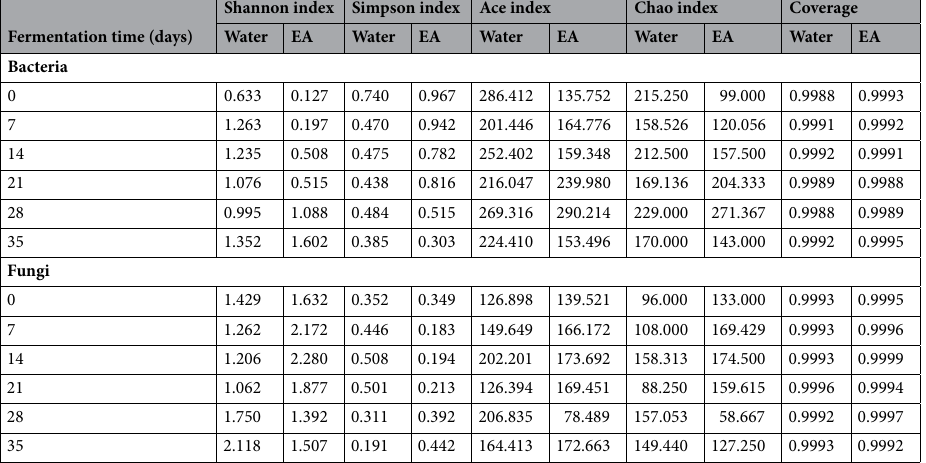
Table 3. Alpha diversity indexes of microbial communities of CTL samples in water- and EA-groups.